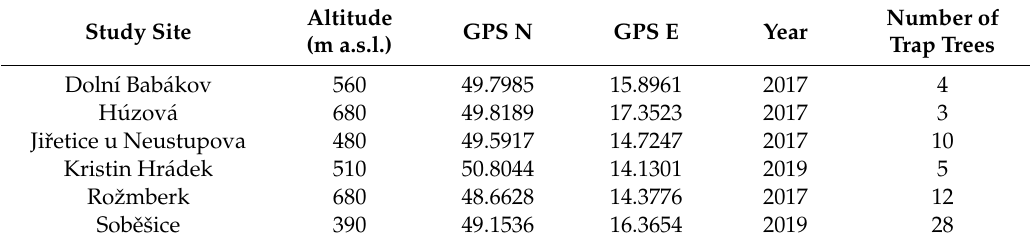
Table 1. Study sites in years 2017–2019 in experiment